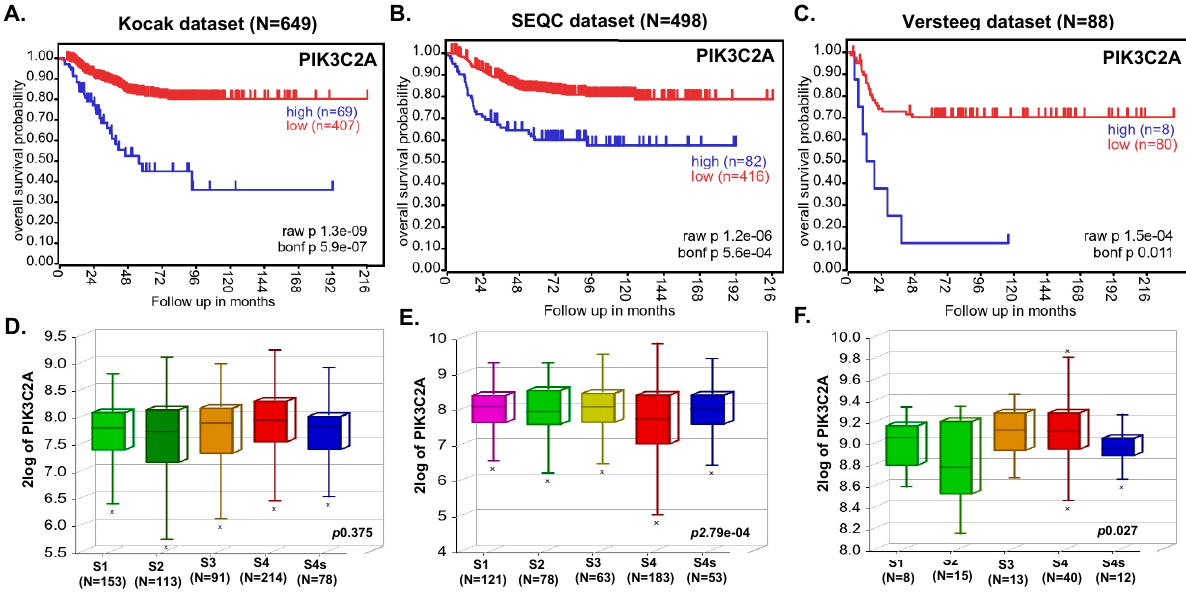
Figure 1. Expression of PIK3C2A gene inversely correlates with overall NB patients’ survival. Kaplan–Meier survival analysis of PIK3C2A gene expression shows an overall inverse probability of NB patients’ survival. ( A ) Kocak (N = 649). ( B ) SEQC (N = 498). ( C ) Versteeg (N = 88). ( D–F ) International Neuroblastoma Staging System (INSS) ‐ based NB stage analysis showing the correlation of PIK3C2A expression with NB progression: ( D ) Kocak dataset, ( E ) SEQC dataset, ( F ) Versteeg dataset. x represents statistical significance within the group.